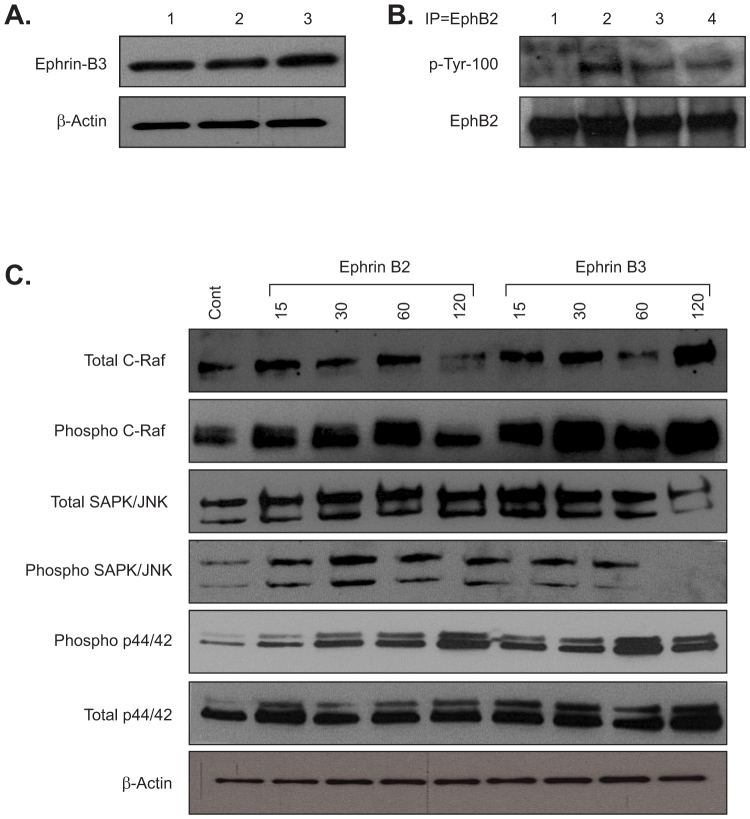
Exogenous but not endogenous ephrin-B ligand can activate EphB2 in EphB2 overexpressing Ink4a/Arf(−/−) STeNSCs (utNSCs).(a) Ephrin-B3 immunoblot of uninfected Ink4a/Arf(−/−) STeNSCs (lane 3) or infected with control (pCX4-RedEX; lane 1) or EphB2 expressing (lane 2) retrovirus. (b) In vitro EphB2 activation assay of utNSCs incubated for 24 hrs. with anti-human-IgG (lane1), ephrin-B1 (lane 2), ephrin-B2 (lane 3), or ephrin-B3 (lane 4). (c) Immunoblot of phospho- and total C-Raf, SAPK/JNK and p44/42 of utNSCs incubated with anti-human-IgG (lane1), and ephrin-B2 or ephrin-B3 for 15, 30, 60, and 120 minutes.